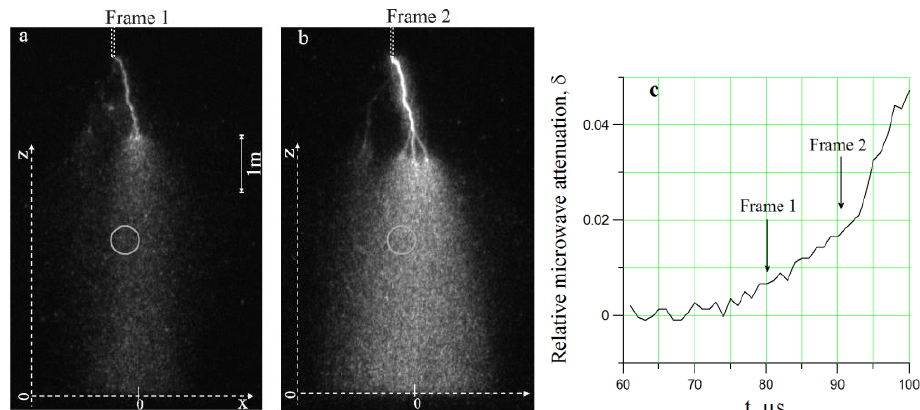
Fig. 4. The breakthrough phase of positive spark. a and b - two consecutive high-speed camera images. The exposure time of each frame is 0.2 μ s, the time delay between the end of the first exposure and the start of the second one is 10 μ s. The circles indicate the position of microwave beam and its diameter at 1/e level of intensity. c - relative attenuation of probing microwave radiation . The times of the two frames are marked.